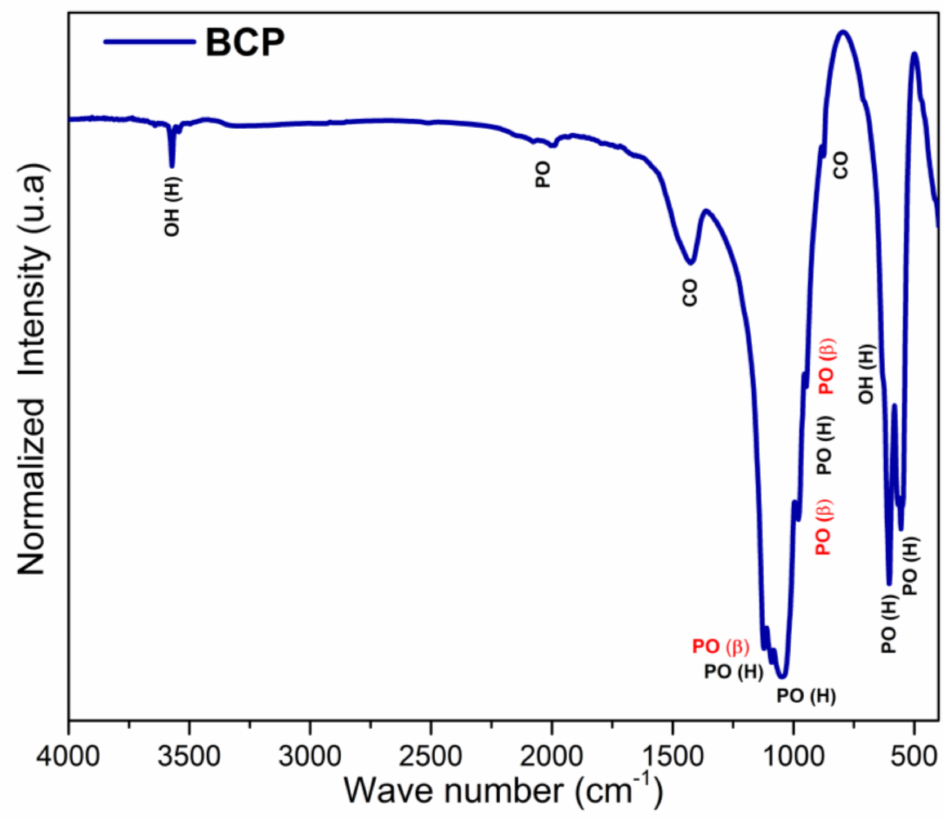
Figure 5. FTIR spectra of BCP powder obtained by calcination and milling of the fish bones. PO (PO 43 − ), OH (OH − ), CO (CO 32 − ), H (Hap) and β ( β -TCP). BCP = biphasic calcium